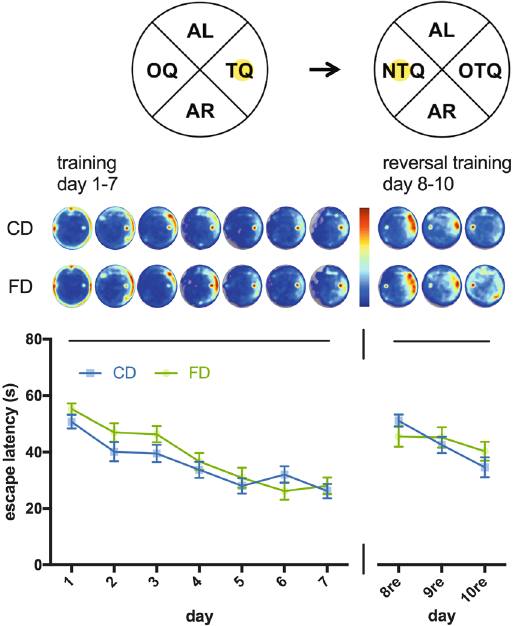
Figure 2. Acquisition and reversal training in the Morris water maze. Visual representations of swim tracks are shown for each day and group. Relative occupancy values during training and reversal training in the Morris water maze are indicated by the colour code (see colour bar; red denotes high occupancy, blue denotes low occupancy values). The yellow circle denotes the platform location during training and reversal training. TQ = target quadrant, AL = adjacent left, AR = adjacent right, OQ = opposite quadrant, OTQ = old target quadrant, NTQ = new target quadrant. CD = F1 offspring of control dams. FD = F1 offspring of dams that received the folic acid-supplemented diet prior to mating. Data are presented as mean ± S.E.M. (CD: n = 24, FD: n =